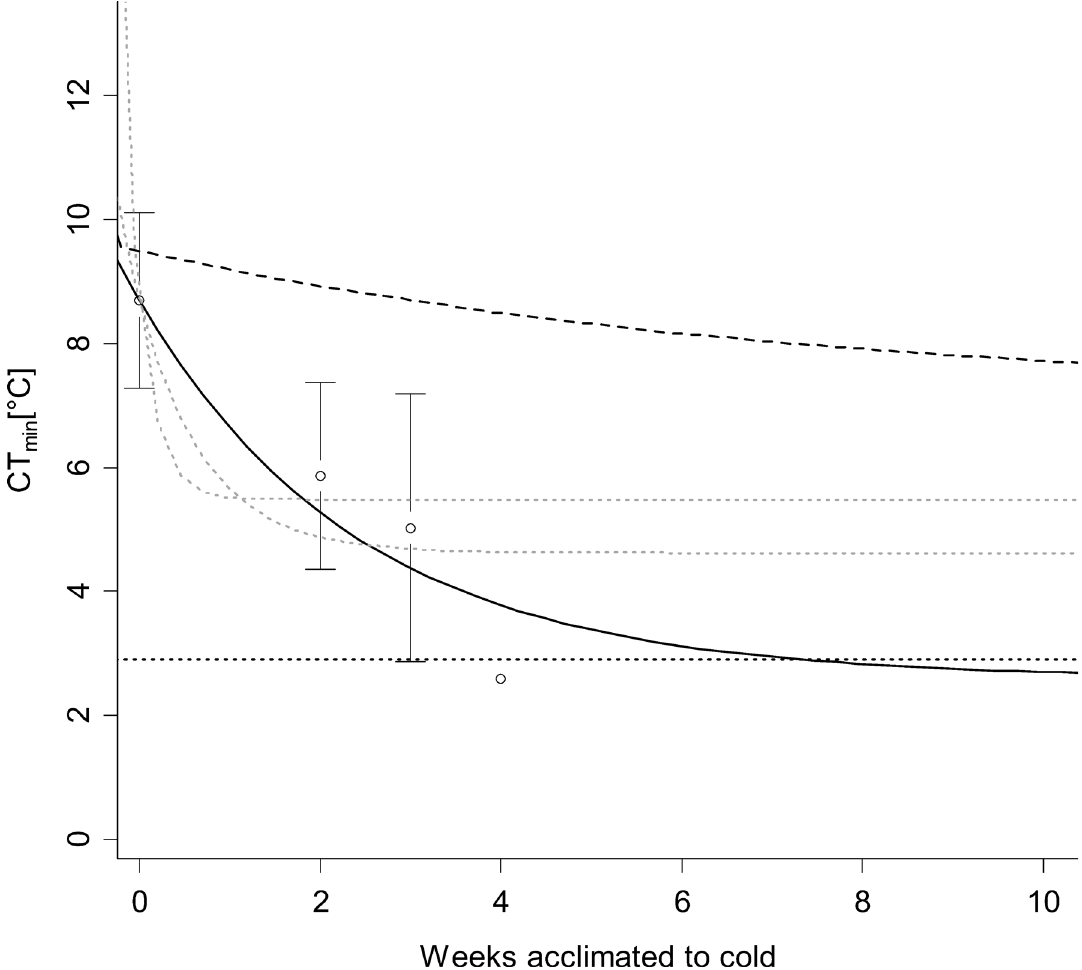
Fig 4. Acclimation of CT min in 22 reptile species. Critical thermal minimum temperatures [°C ± 2SE] of 22 warm acclimated (0 days acclimation) and partially acclimated (2 to 4 weeks acclimation) reptile species. Solid line shows predictions by linear mixed effects model with lowest AIC. Values approach an asymptote of 2.61°C. 95% of acclimation is completed at 7.3 weeks (dotted black reference line). Predictions by other models of inferior fit (dotted black reference line) and acclimation response of Carlia longipes (dashed black line) are shown for comparison. The model of best fit was described by the following